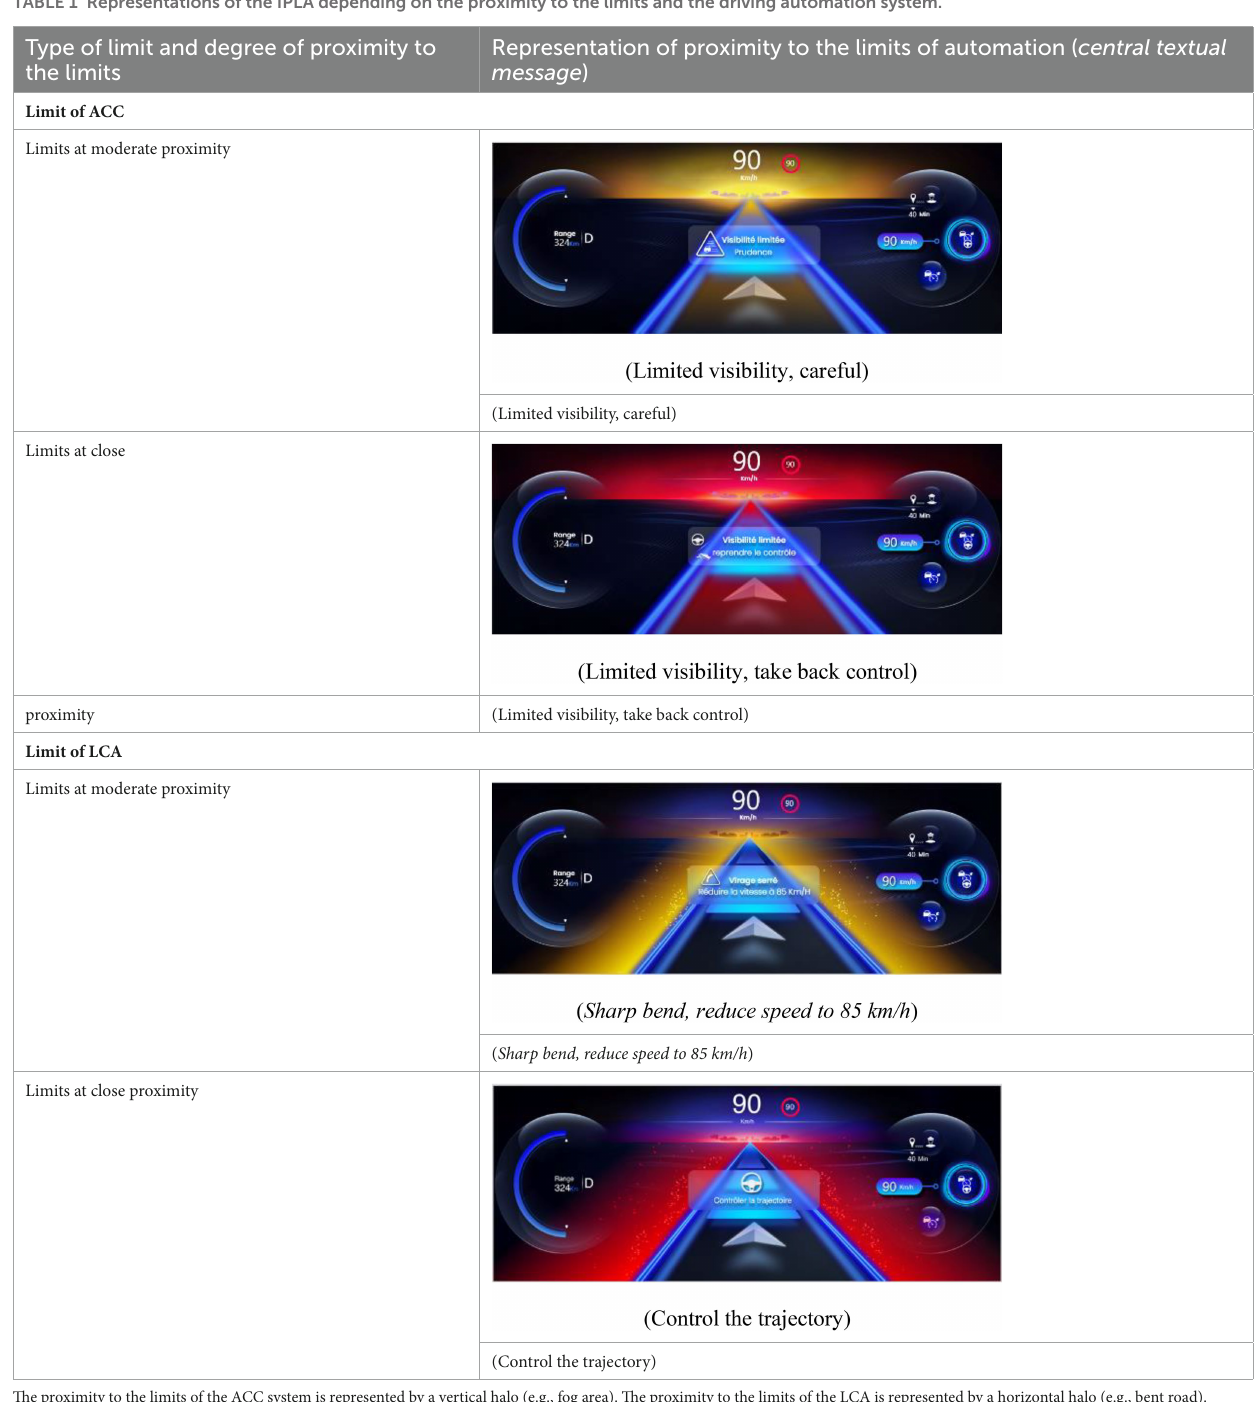
TABLE 1 Representations of the IPLA depending on the proximity to the limits and the driving automation system. Type of limit and degree of proximity to the limits